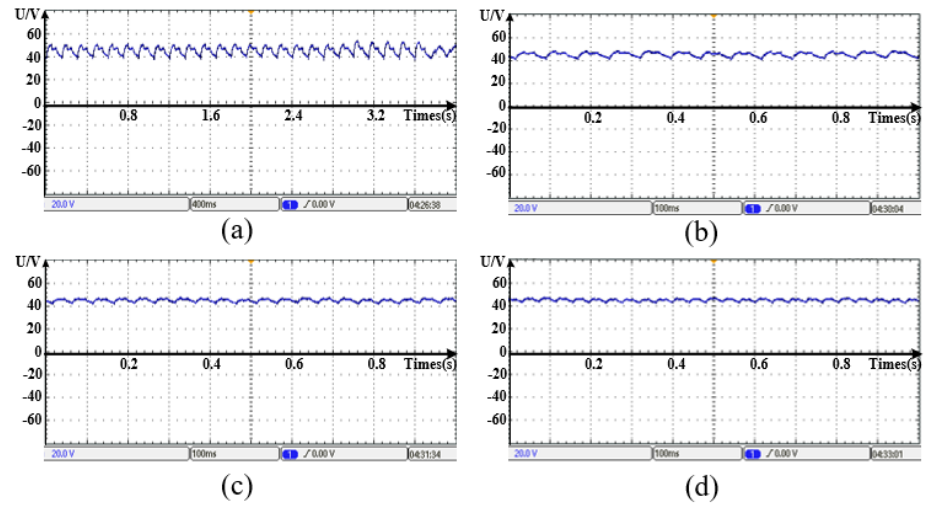
Figure 22. Voltage waveforms of DDSRG at different speeds. ( a ) n = 50 rpm. ( b ) n = 100 rpm. ( c ) n = 150 rpm. ( d ) n = 200 rpm.